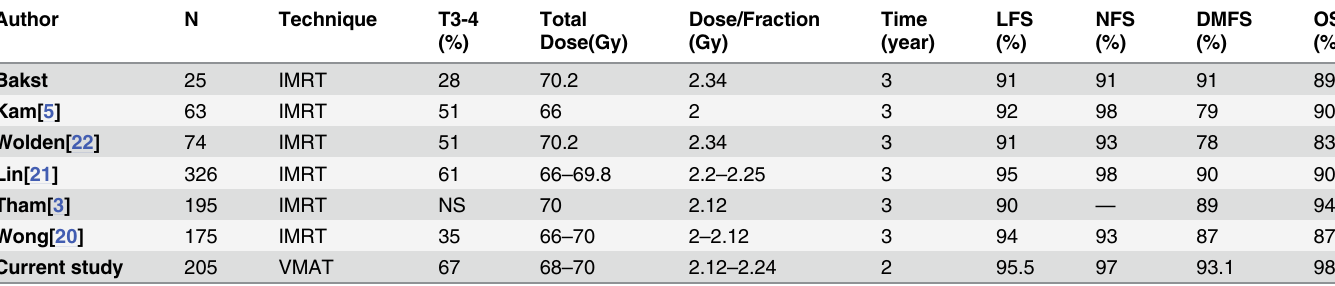
Table 7. Treatment parameters and outcomes of intensity-modulated